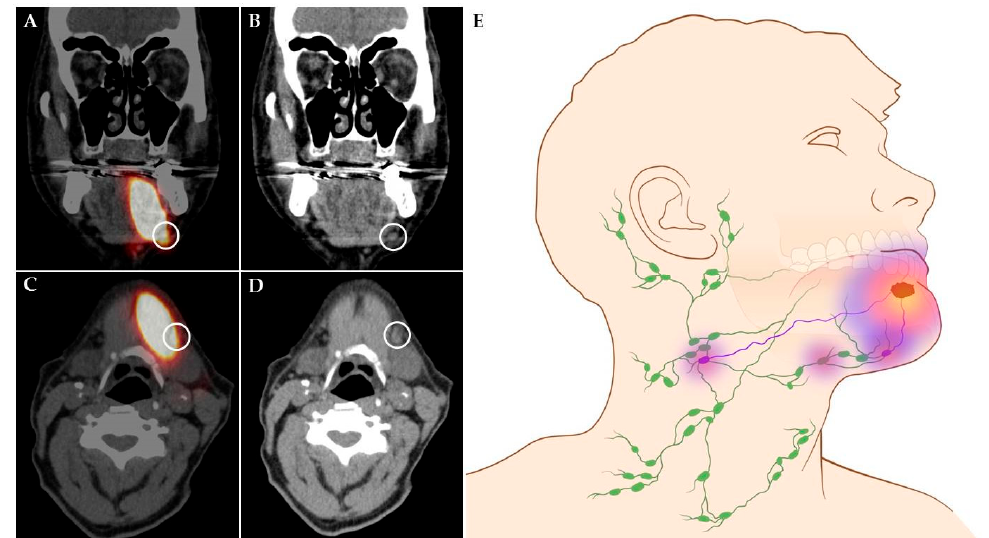
Figure 1. Shine-through phenomenon in 72-year-old patient with a cT1N0 floor-of-mouth carcinoma. ( A , C ) Coronal and axial SPECT-CT images: radiation flare of the tracer injection site over shines a sentinel lymph node located in cervical lymph node level Ib (white circle). ( B , D ) Coronal and axial low-dose CT images of same patient: (sentinel) lymph node located in cervical lymph node level Ib that could not be differentiated from the hotspot originating from tracer injection site on SPECT-CT (white circle). ( E ) Schematic illustration of shine-through phenomenon. ( A – D ) Informed consent has been obtained from this patient. ( E ) © University Medical Center Groningen.